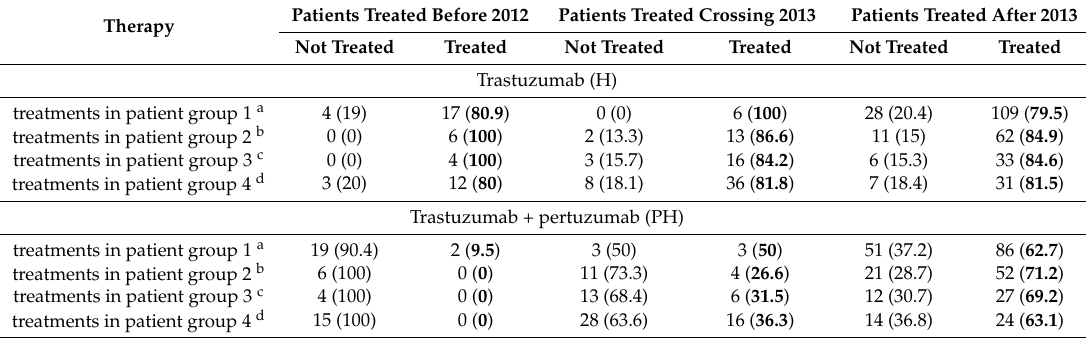
Table 2. Frequencies of patients who received the respective treatments. The patients are categorized here into four mutually exclusive (distinct) patient groups according to the number of documented therapy lines. The percentages of patients treated are marked in bold. The numbers and percentages of treated patients refer to the cumulative number of patients treated up to the highest documented therapy line. For example, in the group of patients with three therapy lines documented and treated after 2013, 33 patients have been treated with trastuzumab in one of the first three therapy lines. Patients Treated Before Therapy